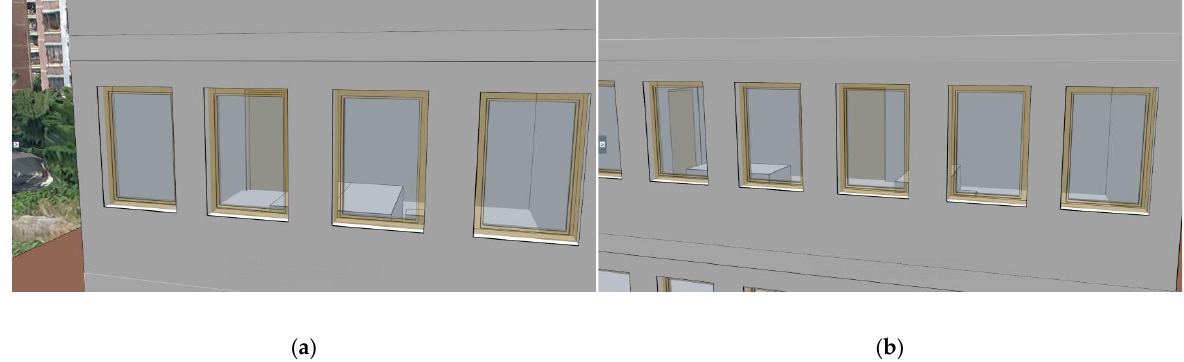
Figure 12. Results of the Liu et al. (2016) method. ( a ) Area 1 and ( b ) area 2 of Figure 11.